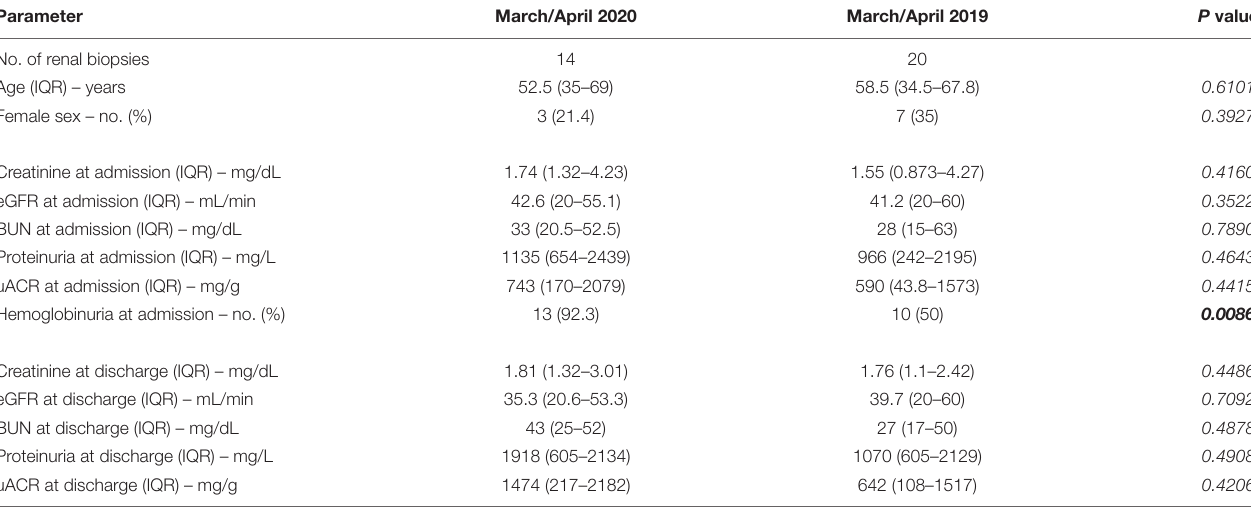
TABLE 3 | Renal biopsies and characteristics of patients comparing the COVID-19 lockdown period 2020 with the same period in 2019.